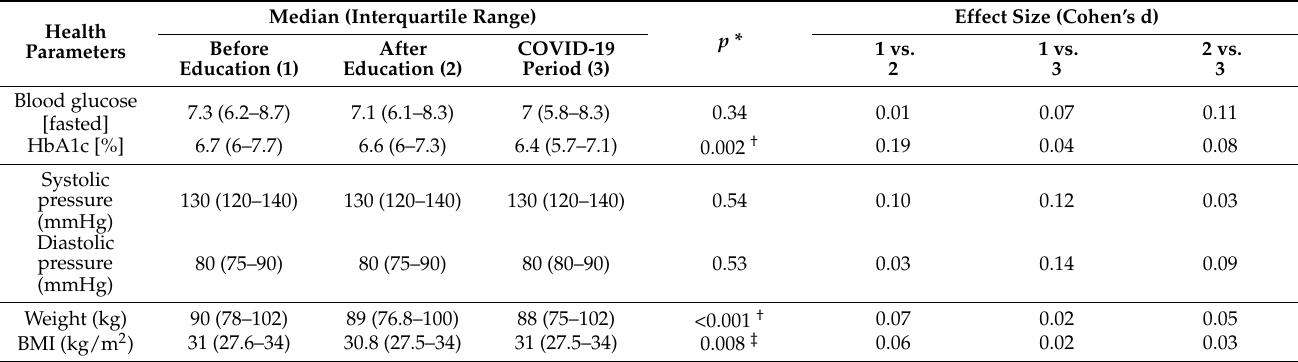
Table 2. Diabetes health parameters before and after education and during the coronavirus disease 2019 (COVID-19) period. Health